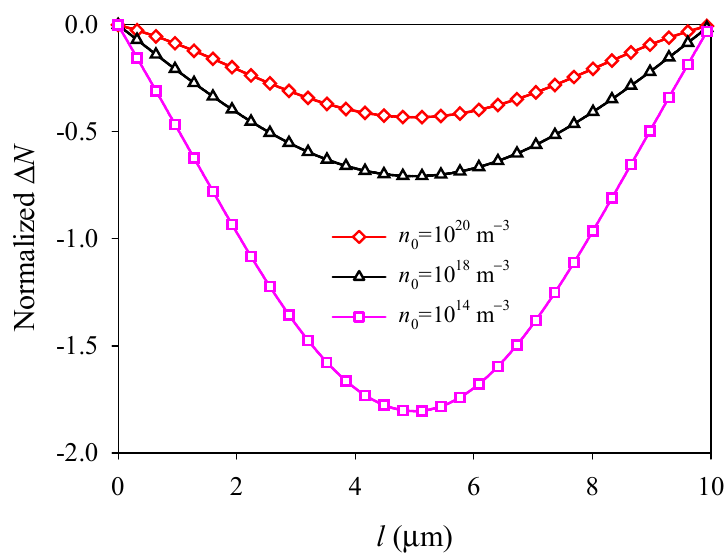
Figure 8. Normalized electron concentration perturbation Δ N along the midline y = d/ 2 versus ini- Figure 7. Electric potential Φ along the midline y = d /2 versus initial electron concentration n 0 . tial electron concentration n 0 .